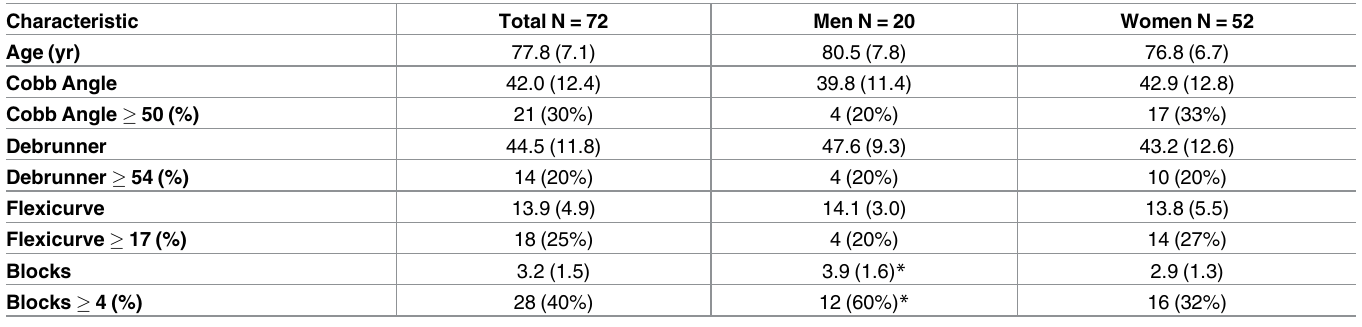
being in good/excellent health (93%), six had prevalent vertebral fractures of grade 2 or more, and 35% of participants reported a fall within the past 12 months (Table 1). Kyphosis measure- ments were separated according to the patient position during the measurement: standing and supine. The means (SD) of standing kyphotic measures were Flexicurve 13.9 (±4.9) and Deb- runner 44.5˚ (±14) and the supine means were Blocks 3.2 (1.5), and Cobb Angle 42.0˚(±12.4) (Table 2). Male participants, on average, were more kyphotic than women as measured by Debrun- ner, flexicurve, and blocks. When setting the criteria for HK (cid:21) 4 blocks, 60% of males were hyperkyphotic compared to only 32% of women (Table 2). Cobb Angle was the only measure to display a greater degree of kyphosis in women compared to men, though the difference was non-significant (p > .05). After adjusting for age, sex, weight, and hip BMD, participants with decreased TLM trended towards greater degrees of kyphosis across all 4 measures (p < 0.05) (Table 3). Although vertebral fracture did not make screening criteria to be entered into the multivari- able model, additional adjustment for prevalent vertebral fracture made no difference in the results. Similarly, using the previously described cut-off threshold(s) to define persons as hyperkyphotic, significant associations were detected between TLM and the standing measures of kyphosis. Participants with less TLM were at greater risk of being hyperkyphotic according Table 2. Mean kyphosis values and percent prevalenceof